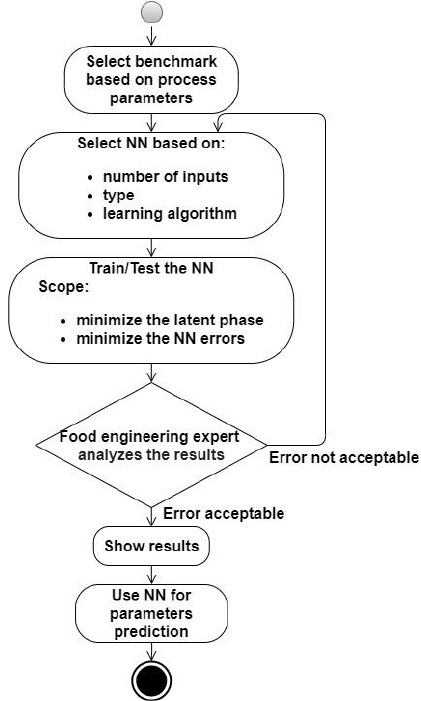
Figure 3. The scheme of the experiments’ organization.